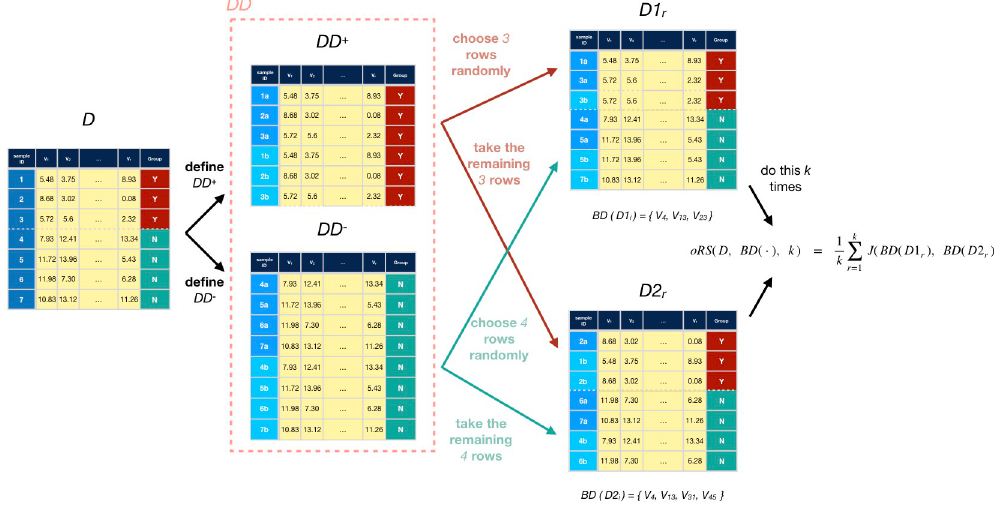
Fig 2. Computing oRS. Diagram showing oRS’s process of generating pairs of subsets for a dataset D ( k times), then using those to compute oRS(D, BD( � ), k).